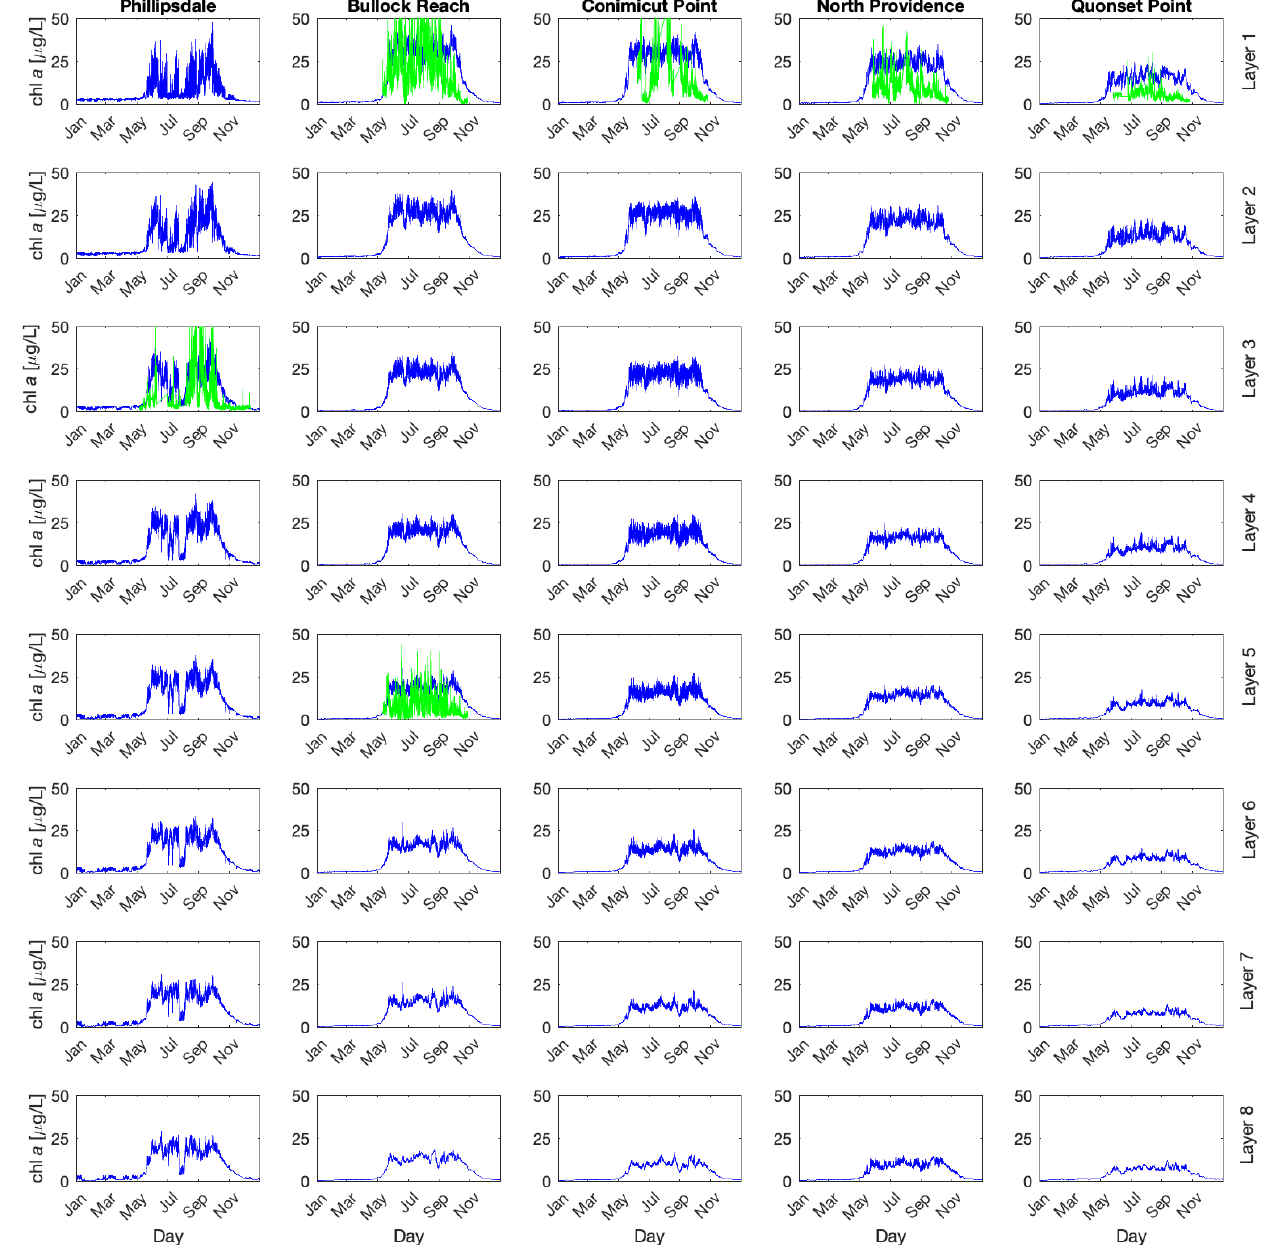
Figure 5. Chlorophyll a concentrations in µ g L − 1 in Narragansett Bay at 5 locations with depth. Each column represents where there is observed data, from north to south along the West Passage. Each row represents a water column layer, from Layer 1 at the surface to Layer 8 right above the sediments. The solid blue lines represent the WASP simulation output. The solid green lines are the observed sonde data.